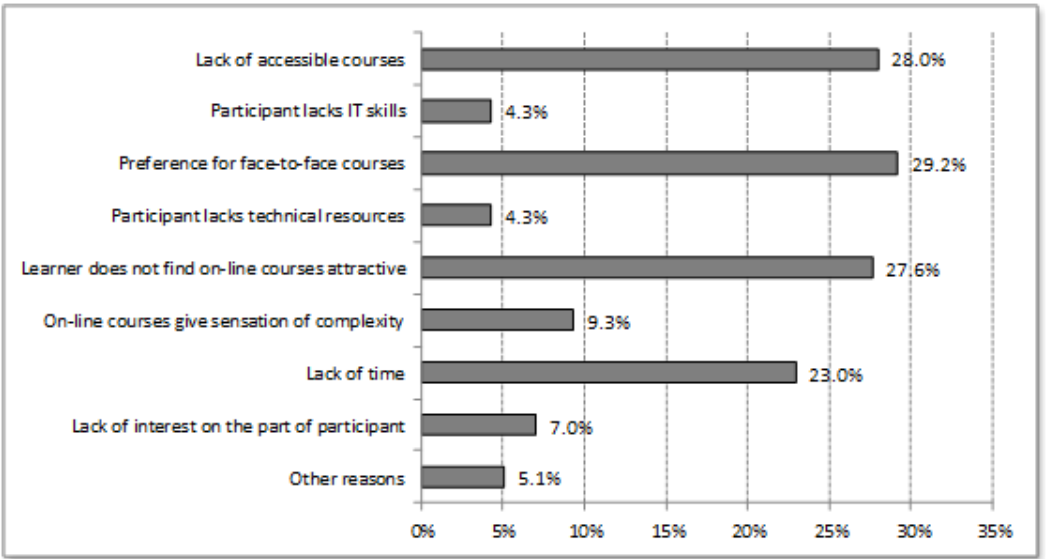
Figure 6. Reasons alleged by deaf and hard of hearing individuals not to engage in e-learning activities (relative data). Multiple answers possible. Valid answers: